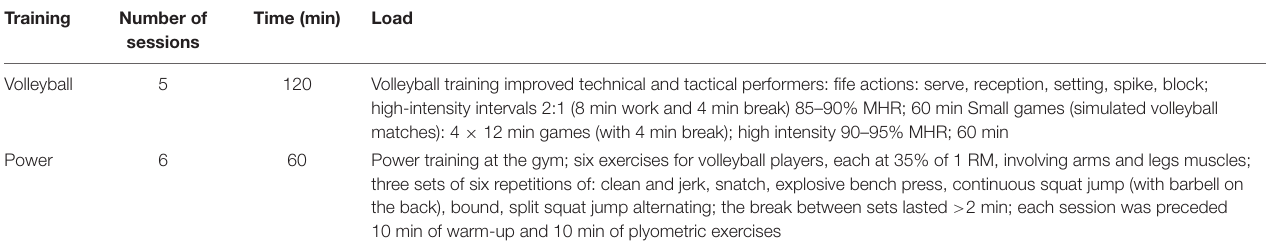
TABLE 1 | Characteristics of training sessions.